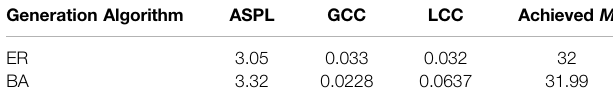
TABLE 1 | Simulation results for Bitcoin. Targeted M was 32.